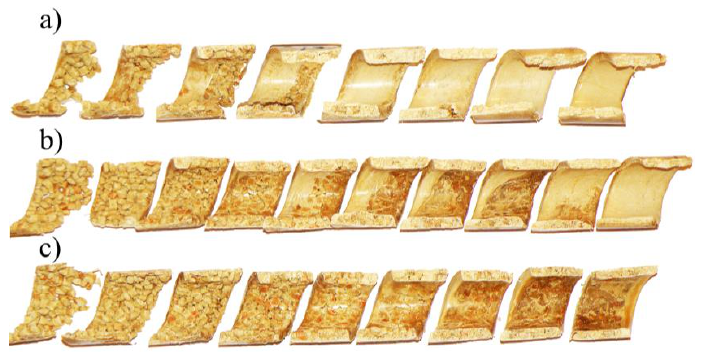
Figure 4. The effect of screw speed on the material flow in the screw channel (samples of the material of 40% WF content removed from the screw): ( a ) N = 20 rpm, ( b ) N = 50 rpm, ( c ) N = 80 rpm.